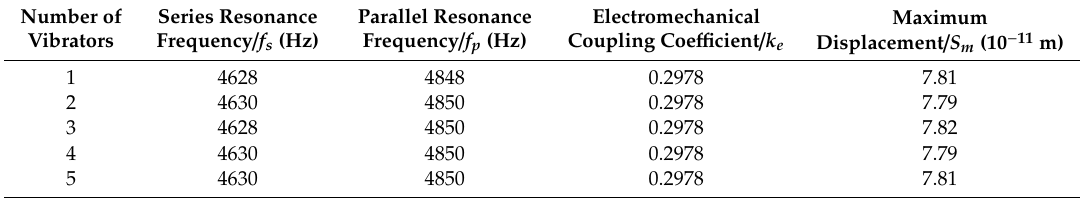
Table 3. Performance parameters of the 2 ‐ 2 piezoelectric composite bilaminated vibrator Number of